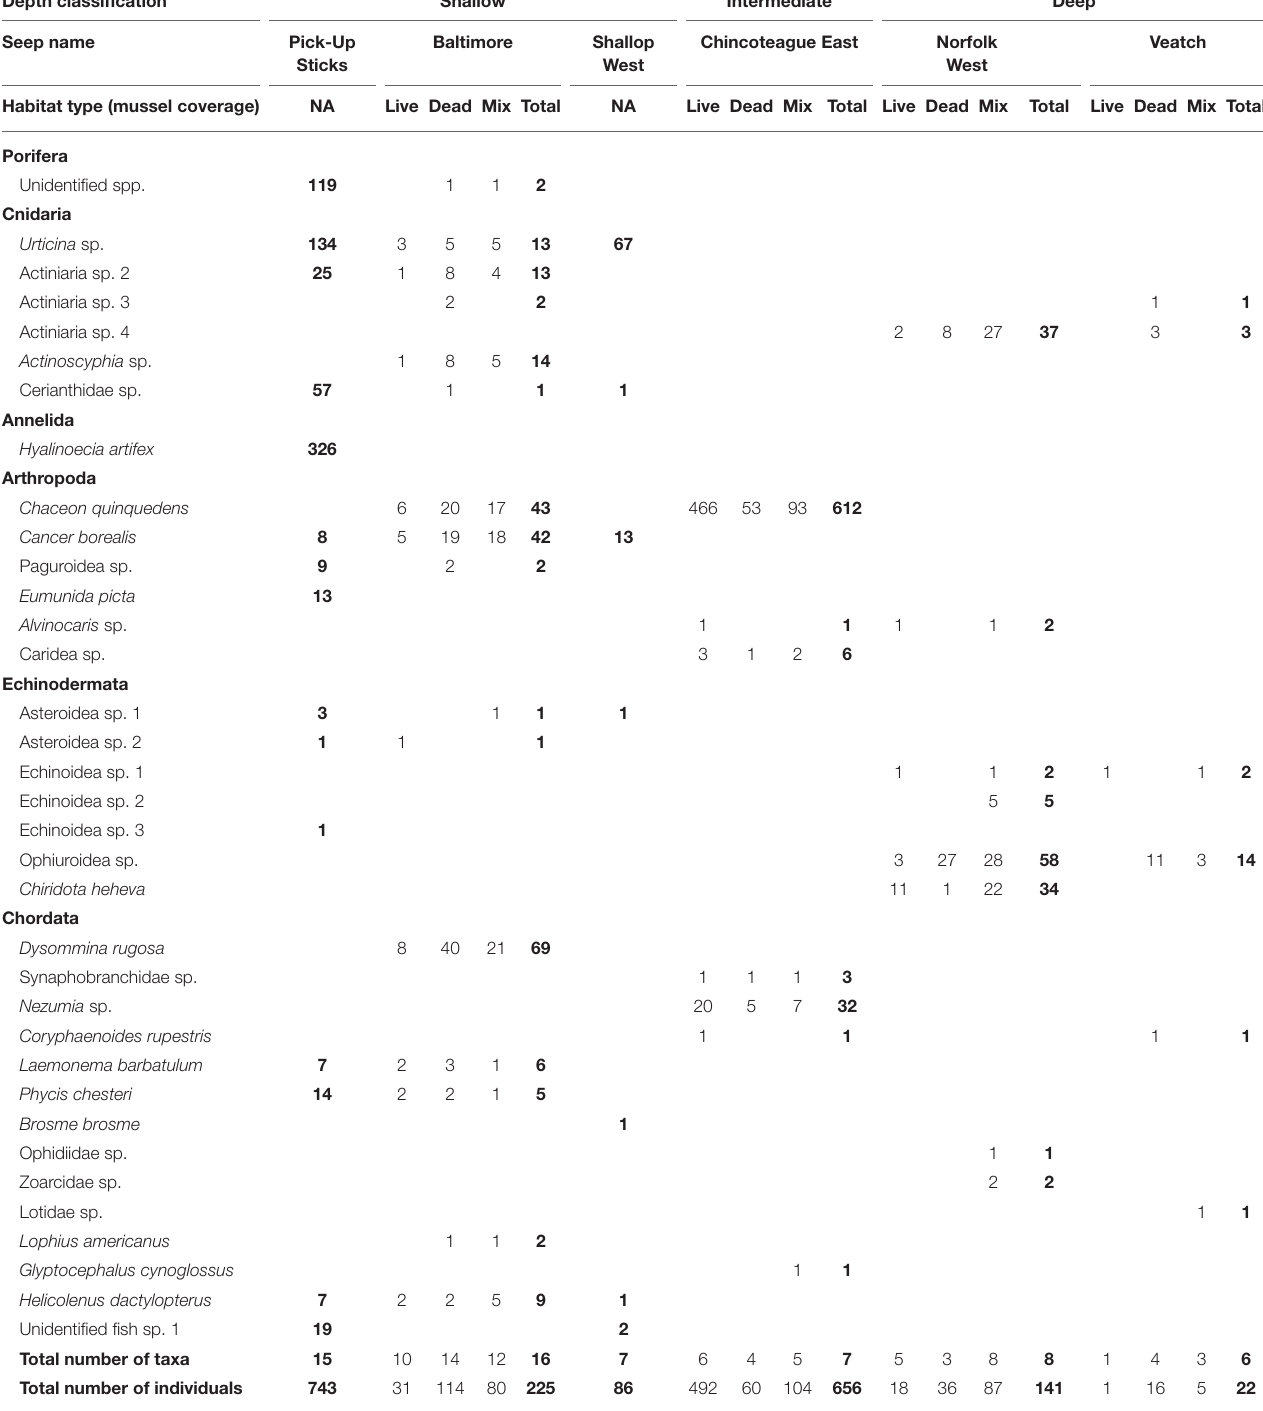
TABLE 2 | Taxon abundance table from photo transect